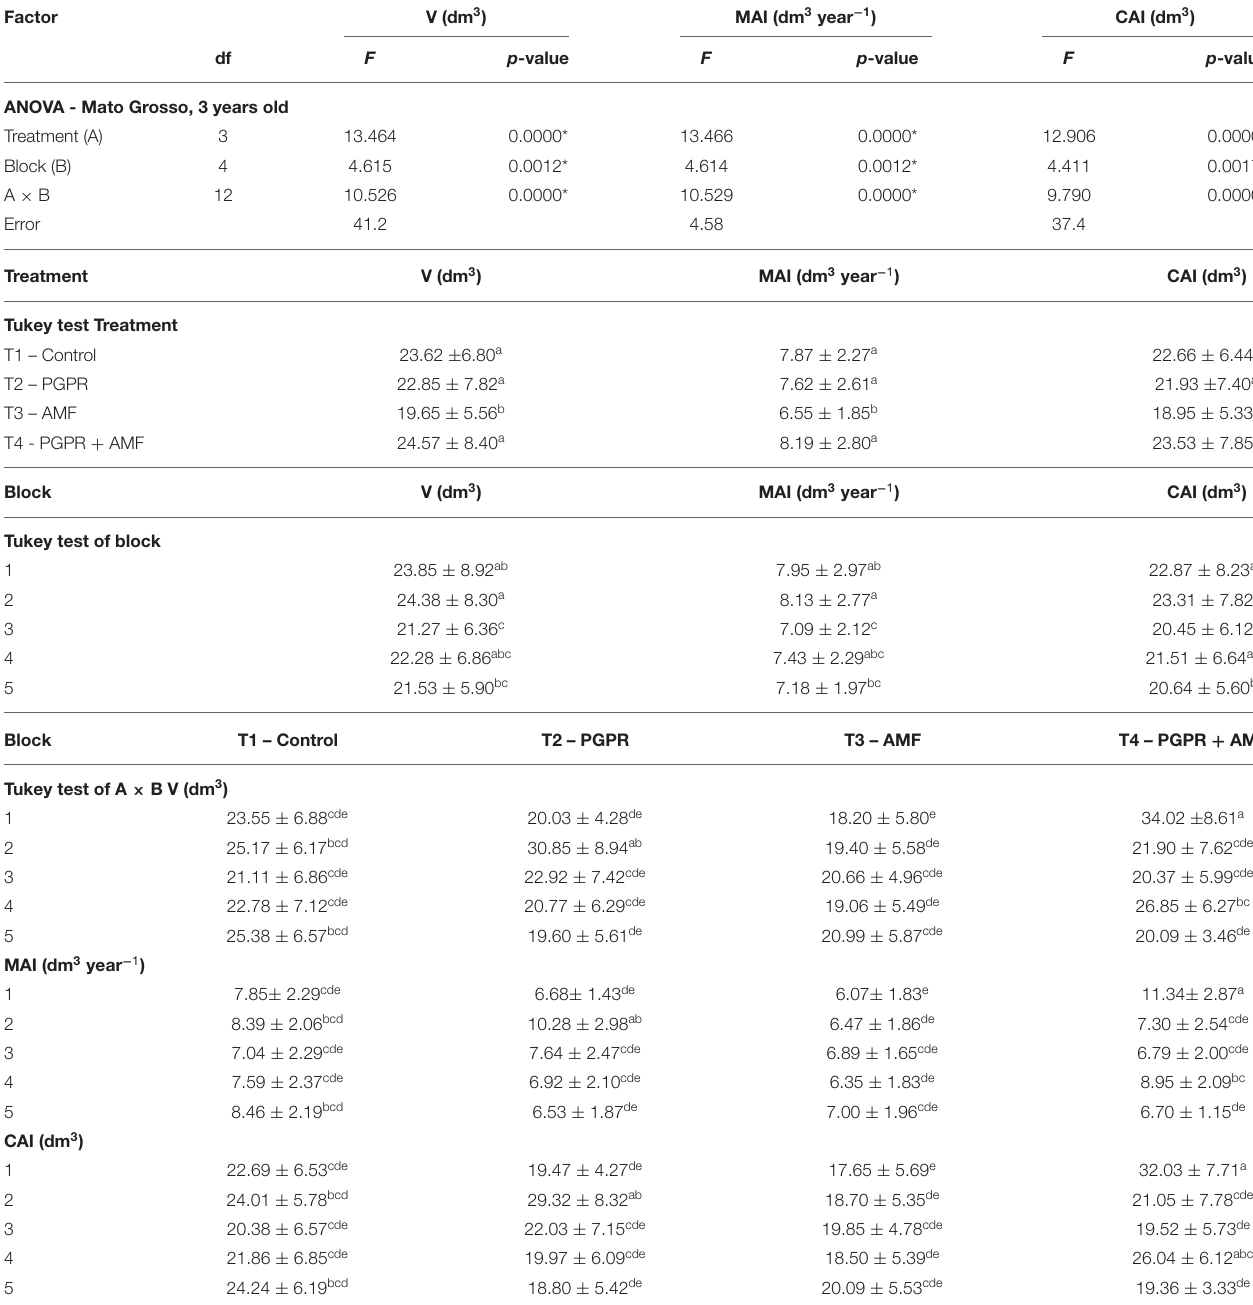
TABLE 7 | Tree volume, mean annual increment, and current annual increment at 3 years old in plants of Tectona grandis in Mato Grosso state,